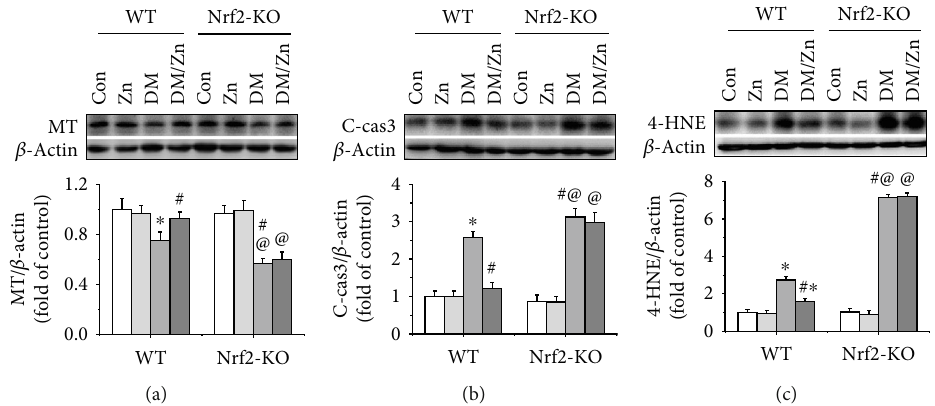
Figure 10: The role of endogenous Nrf2 in zinc supplementation-induced hepatic MT increase under type 2 diabetic condition. HFD/STZ strategy was applied in both WT and Nrf2-KO mice to induce type 2 diabetes, followed by 3 months of zinc supplementation. After the mice were sacri fi ced, the liver tissues from each group were isolated. Hepatic MT (a), cleaved-caspase3 (b), and 4-HNE (c) were determined by western blot. Data are presented as the mean ± standard deviation ( n = 8 /group). ∗ P < 0 : 05 vs. the control (Con) group in WT mice; # P < 0 : 05 vs. the type 2 diabetes (DM) group in WT mice; @ P < 0 : 05 vs. the control (Con) group in Nrf2-KO